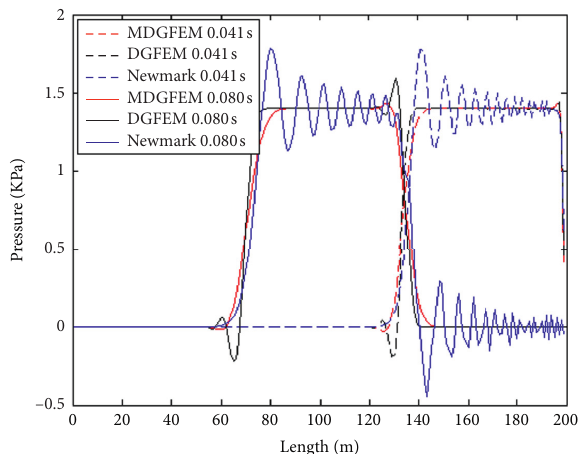
Figure 3: Gas pressure profiles of different methods at t � 0.041 s and t �